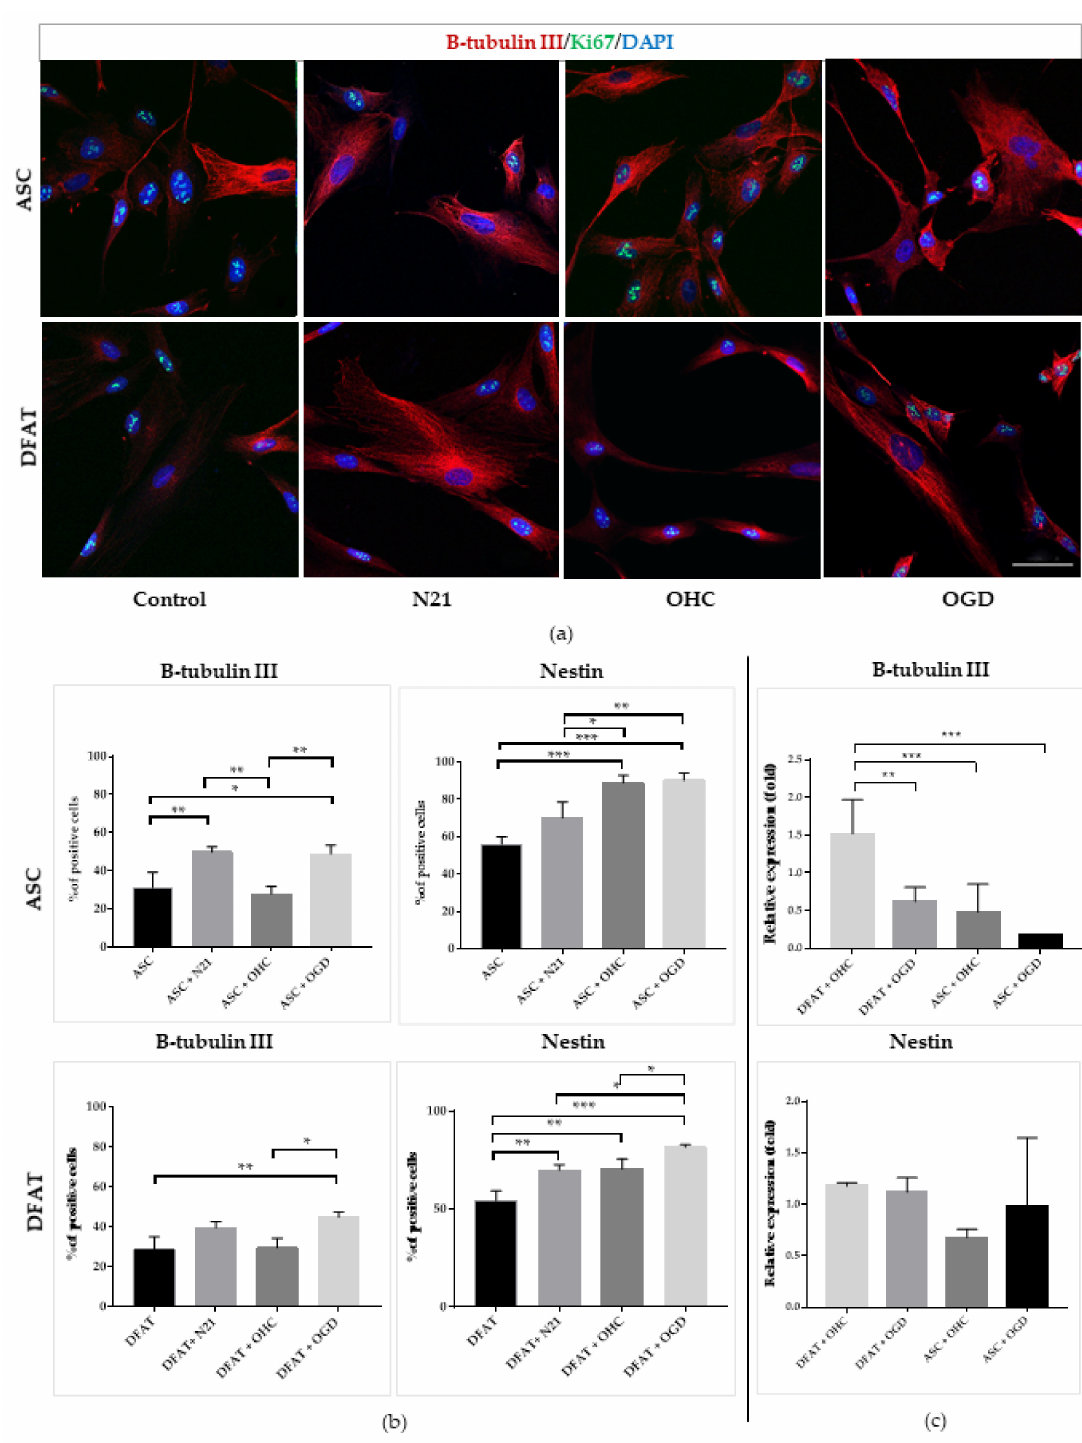
Figure 8. Neural differentiation of ASCs/DFAT cells. B-tubulin III, Nestin immunocytochemical/expression analysis. ( a ) Immunofluorescent images of ASCs/DFAT cells B-tubulin III staining; ( b ) Quantitative analysis of neural markers presence in different culture conditions; ( c ) Neural markers (B-tubulin III and Nestin) expression. The results are presented as mean values of three experiments ± SEM. The differences were considered statistically significant when p -value < 0.05. Statistical significance level * for 0.01 < p < 0.05; ** for 0.001 < p < 0.01; *** for 0.0001 < p < 0.001; **** for p <